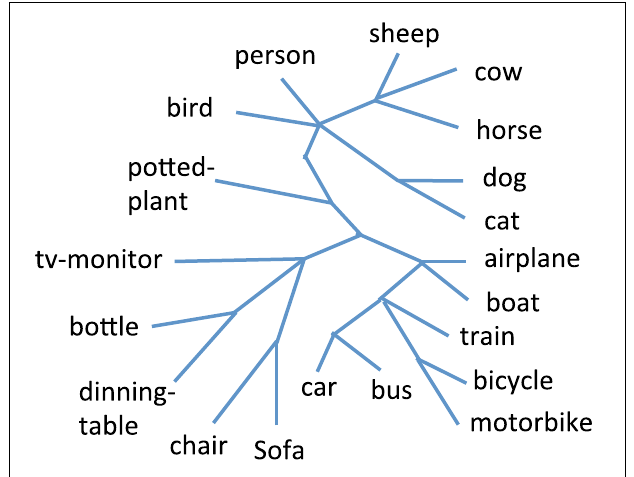
FIGURE 4 | The taxonomy for the 20 categories in the PASCAL